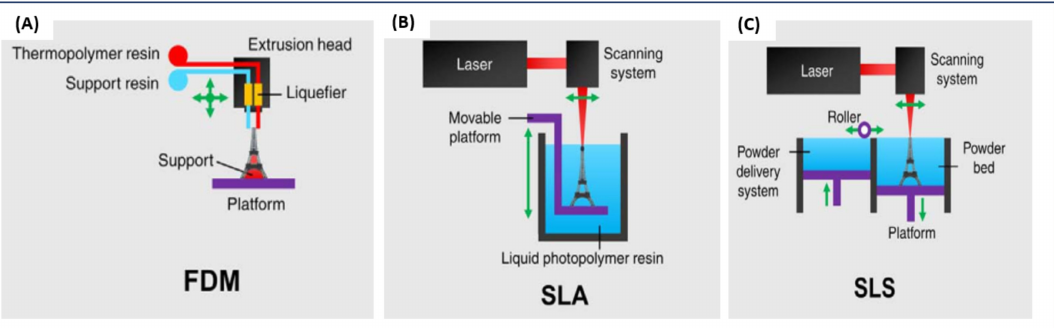
Figure 2. Schematic illustrations of 3D printing technologies. ( A ) FDM printing. ( B ) SLA printing. ( C ) SLS printing. [5]. Adapted from Low, Z.-X.; Chua, Y.T.; Ray, B.M.; Mattia, D.; Metcalfe, I.S.; Patterson, D.A. Perspective on 3D Printing of Separation Membranes and Comparison to Related Unconventional Fabrication Techniques, Journal of Membrane Science; Published by Elsevier,